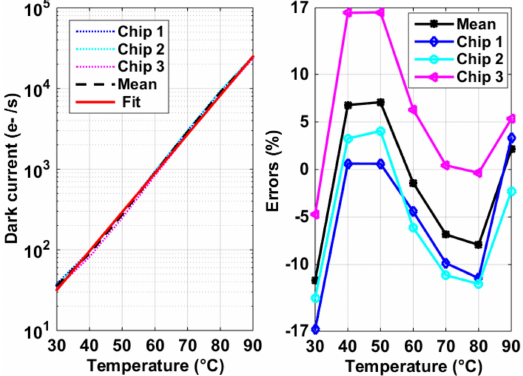
Figure 17. Measured average dark current for three chips and their exponential fit ( left ) and deviations from the exponential fit ( right ).